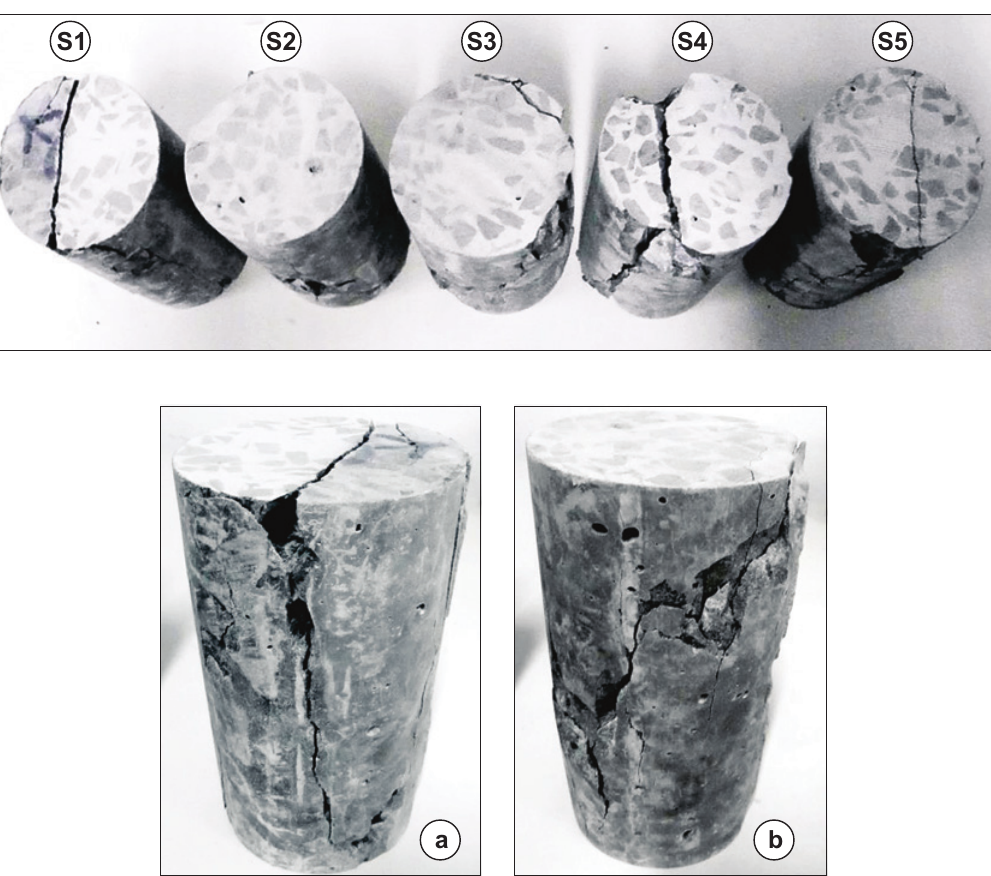
View of failure configurations of samples cast in horizontal position: (above) top view of all samples, (below) (a) Sample S1, (b) Sample S2